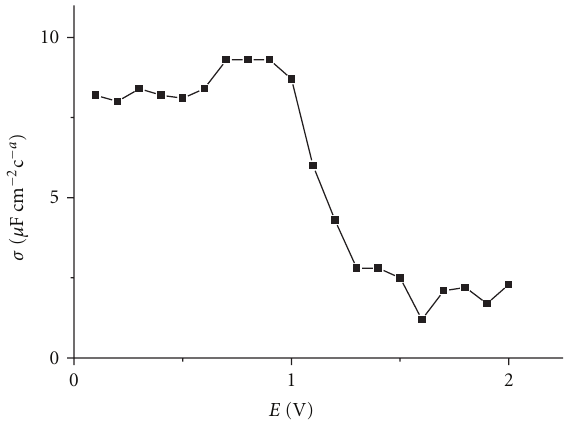
Figure 13: Potential dependence of σ in phenol-containing solu- tion. Compare the background curve 2 in Figure